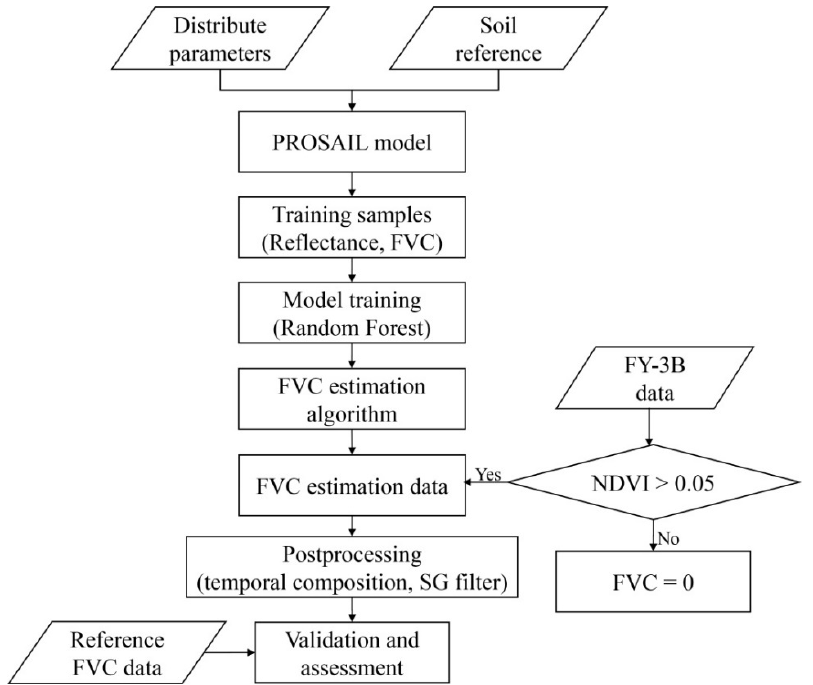
Figure 1. FVC estimation algorithm flowchart for the FY-3B reflectance data.